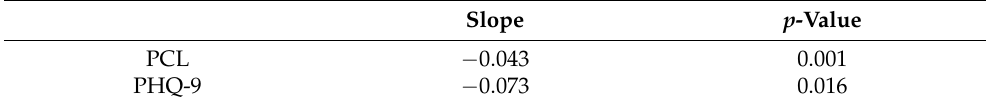
Table 2. Univariate linear regressions of MoCA scores on PCL/PHQ-9 scores.